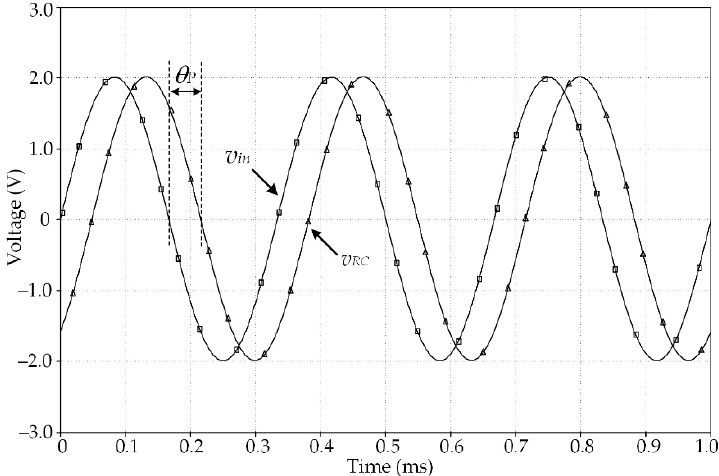
Figure 3. Simulation result of Figure 2b.